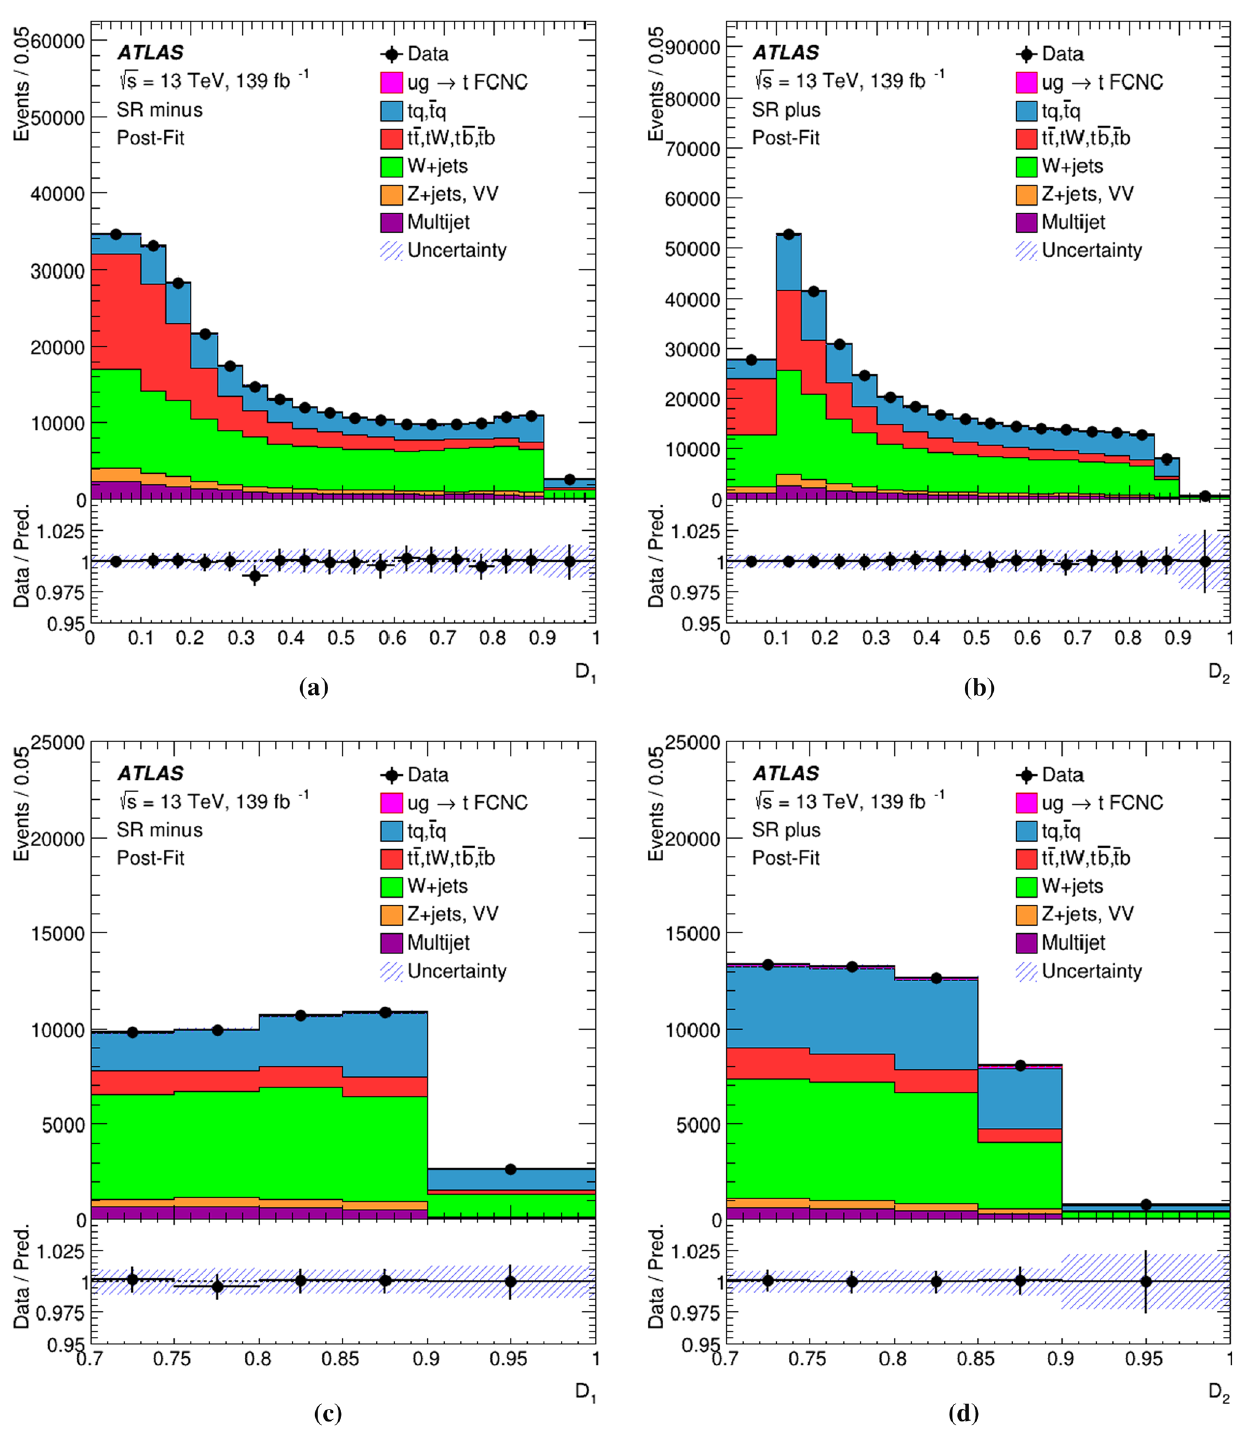
Fig. 6 The NN discriminants D 1 and D 2 of the ugt search are shown with the post-fit normalisation applied to the stacked histograms of the different hard-scattering processes. The histograms in a and b show the full discriminant range in the negatively charged lepton channel and the positively charged lepton channel, respectively. The histograms c